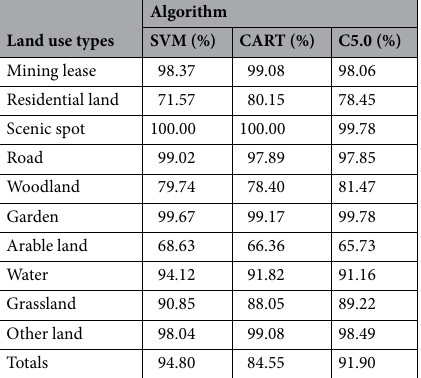
Table 5. Accuracy of each algorithm in various land use types in non-mining areas.